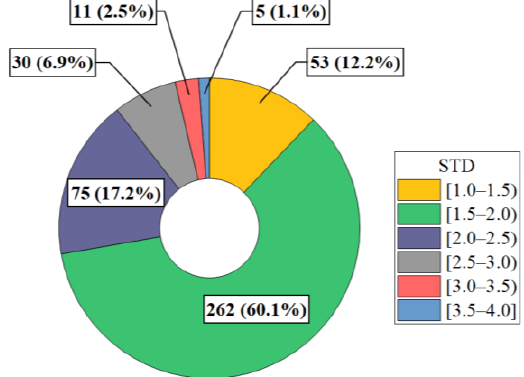
Figure 2. STD distribution statistics of the 436 IGS stations’ ZTD.